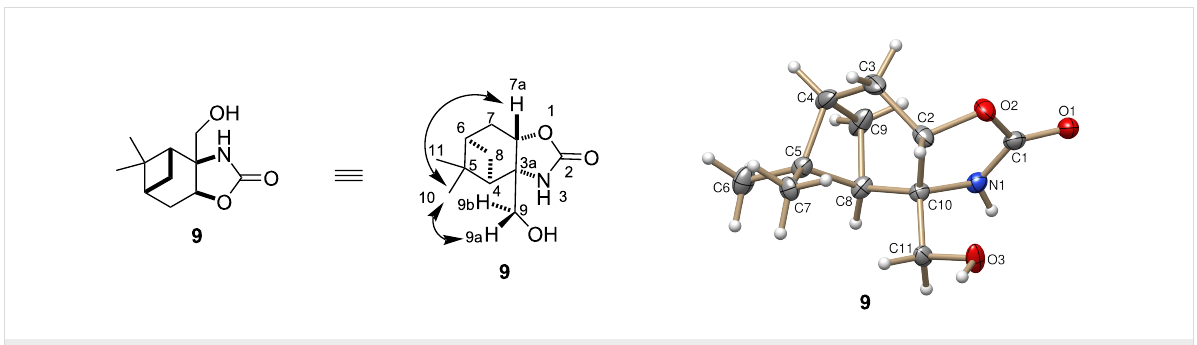
(Scheme 2). The synthetic method was similar to that mentioned above for ( − )-isopinocarveol. In the first step, carba- mate 11 was prepared [37], then the aminohydroxylation was carried out catalyzed by potassium osmate(VI), which led to the formation of the spiro-oxazolidine-2-one 12 in a highly regio- and stereoselective manner. Based on the NMR spectroscopic measurements of the crude product, the spiro derivative 12 was obtained exclusively with the relative configuration depicted in Scheme 2. Beside 2D NMR spectroscopic studies, the absolute configuration of compound 12 was determined by its transfor- mation into the corresponding aminodiols 13 and 14 , comparing the products with those obtained from the regioisomer 9 (dis- cussed in Scheme